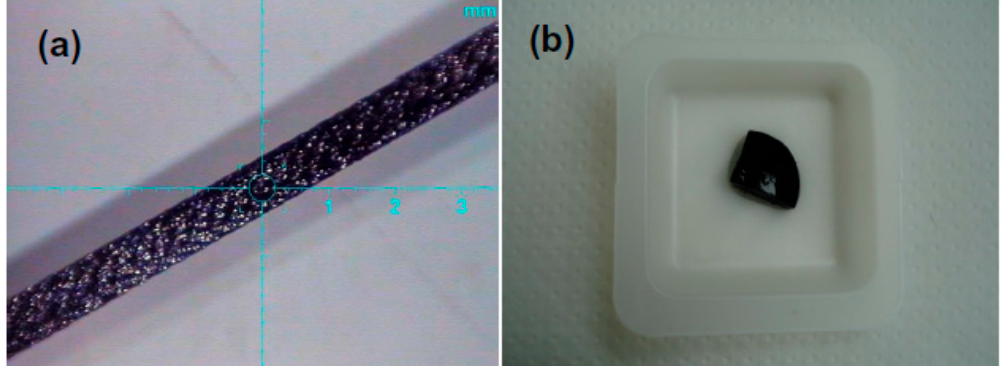
Figure 1. General view in optical microscope of the free surface of Co 68.6 Fe 3.9 Mo 3.0 Si 12.0 B 12.5 rapidly quenched amorphous ribbon based MI sensitive element ( a ); general macroscopic view of xanthan-based ferrogel FG-2a with magnetite magnetic particles in 3.19 weight % concentration ( b ).